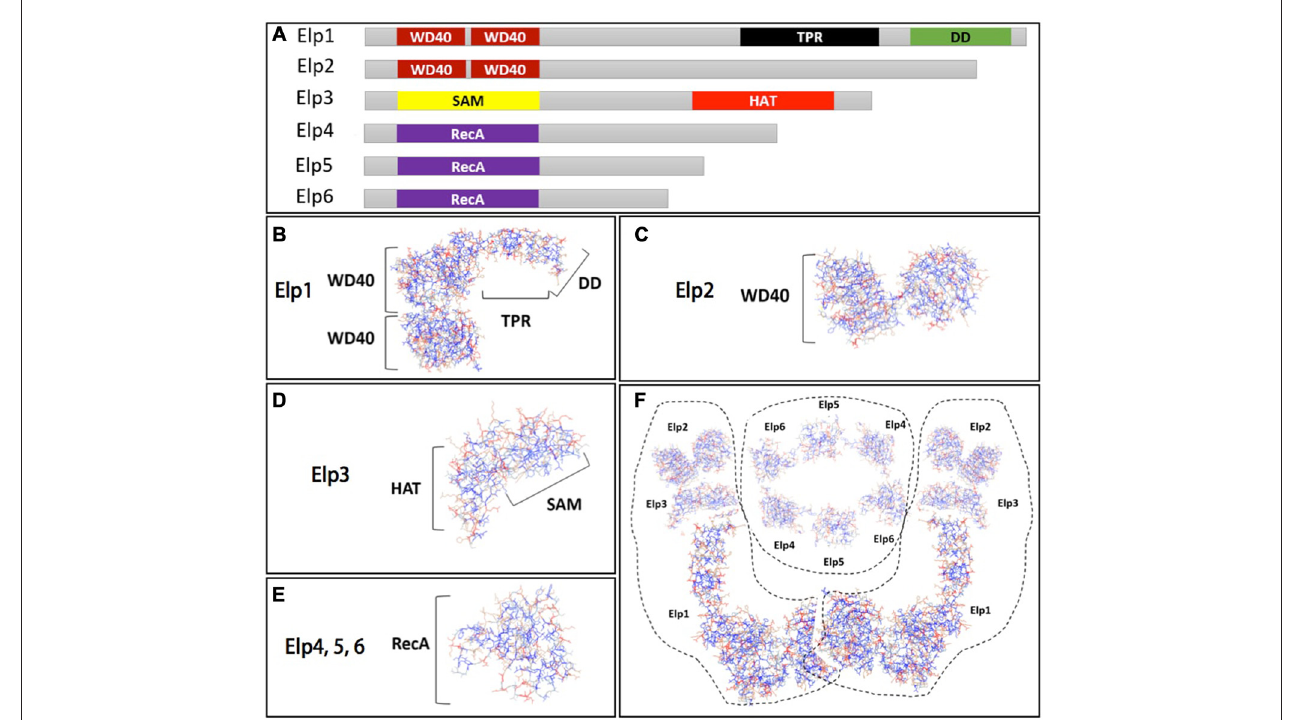
FIGURE 1 | The Elongator complex architecture. (A) Schematic view of Elongator subunits (Elp1–6) and their domain structure highlighted by different colors. Structural model of: (B) Elp1 harboring two WD40 propeller domains, tetratricopeptide repeat (TRP) and DD domain; (C) Elp2 containing two WD40 propeller domains; (D) Elp3 with histone acetyl-transferase (HAT) and S-adenosyl-L-methionine (SAM) domain (E) and Elp4, 5 and 6 subunits that share a RecA fold. (F) The Elongator complex assembly in dodecamer with two Elp123 trimeric sub-complexes peripherally attached to the ring-like hexameric Elp456 sub-complex. Structural models of Elp1–6 were prepared using program Phyre2 (Kelley and Sternberg,